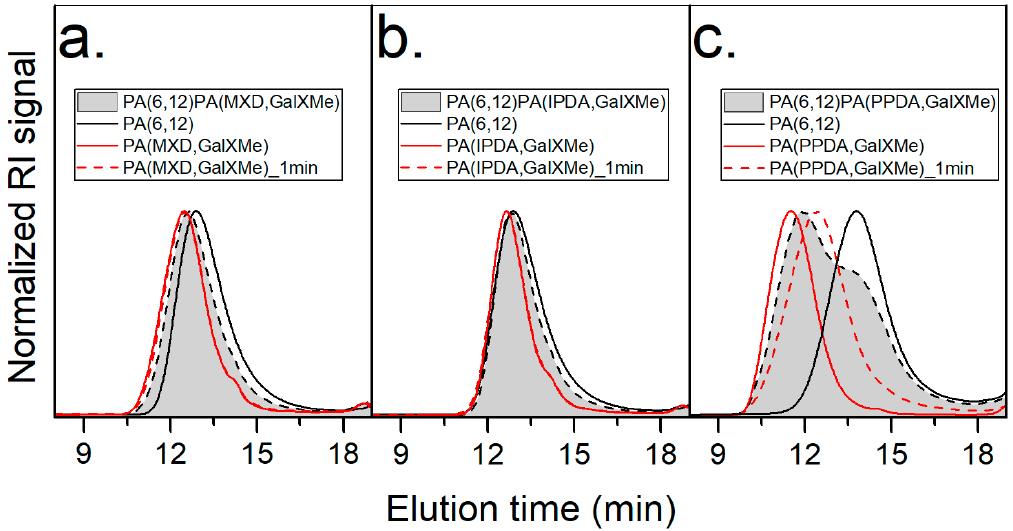
Figure 3. Overlay of the gel permeation chromatography (GPC) traces of the two homopolymers (GalXMe PA ___ and PA(6,12) ___), homopolymer of GalXMe after 1 min of extrusion at 260/270 °C (---), and blend of the corresponding homopolymers after 1 min of extrusion at 260/270 °C ( grey ) ( a ) PA(MXD,GalXMe), ( b ) PA(IPDA,GalXMe), and ( c ) PA(PPDA,GalXMe) blend. RI: refractive index.